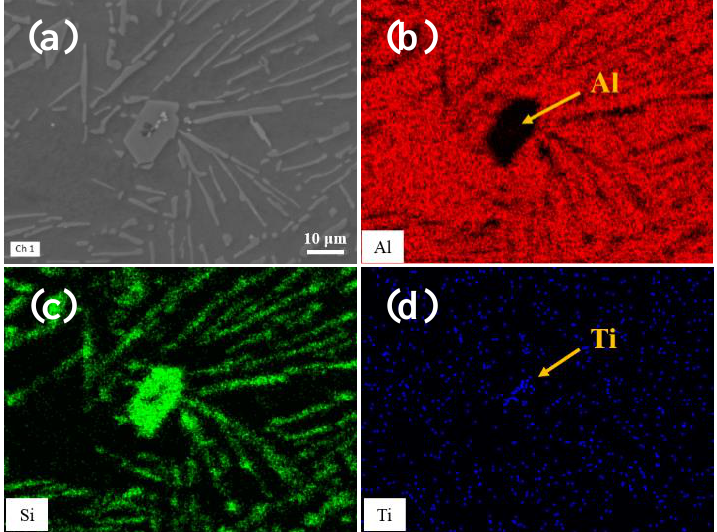
Figure 5. Element distribution at the primary silicon of the A2 alloy. ( a ) Morphology of primary Si, ( b ) Al element, ( c ) Si element, ( d ) Ti element.